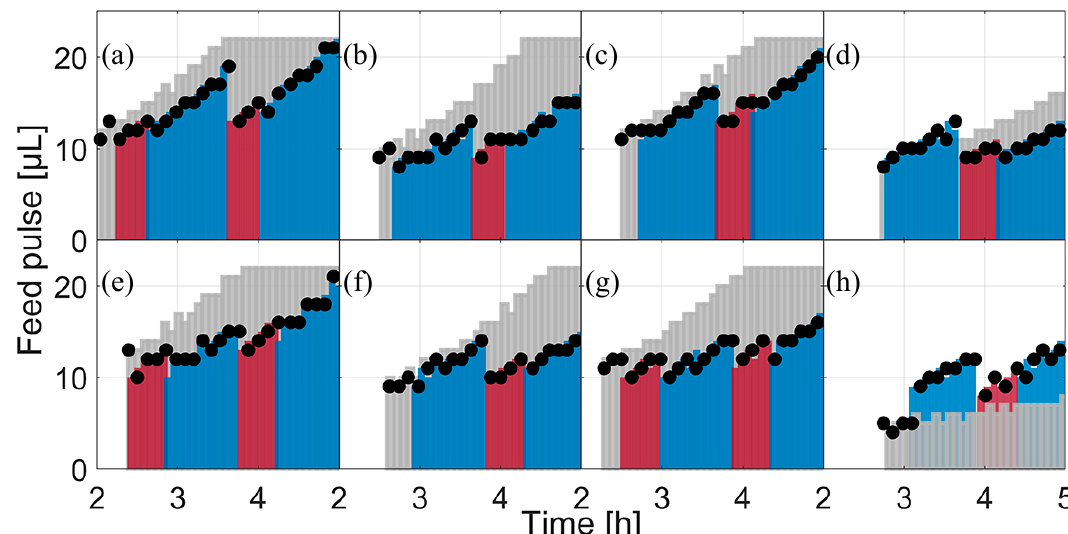
Figure 5. The applied feed and scheduled feeds for each clone between cultivation hours 2 and 5. Black dots: the applied feed based on the real executed feed, logged by the LHS. Light grey bars: scheduled feed at feed start. Colored bars: scheduled feeds in the following modelling cycles; the color change indicates the next modelling cycle. ( a ) E. coli W3110; ( b ) E. coli BW25113; ( c ) E. coli BW25113 Δ ompT ; ( d ) E. coli BW25113 Δ aceA ; ( e ) E. coli BW25113 Δ fliA ; ( f ) E. coli BW25113 Δ gatC ; ( g ) E. coli BW25113 Δ gatZ ; ( h ) E. coli BW25113 Δ glcB.